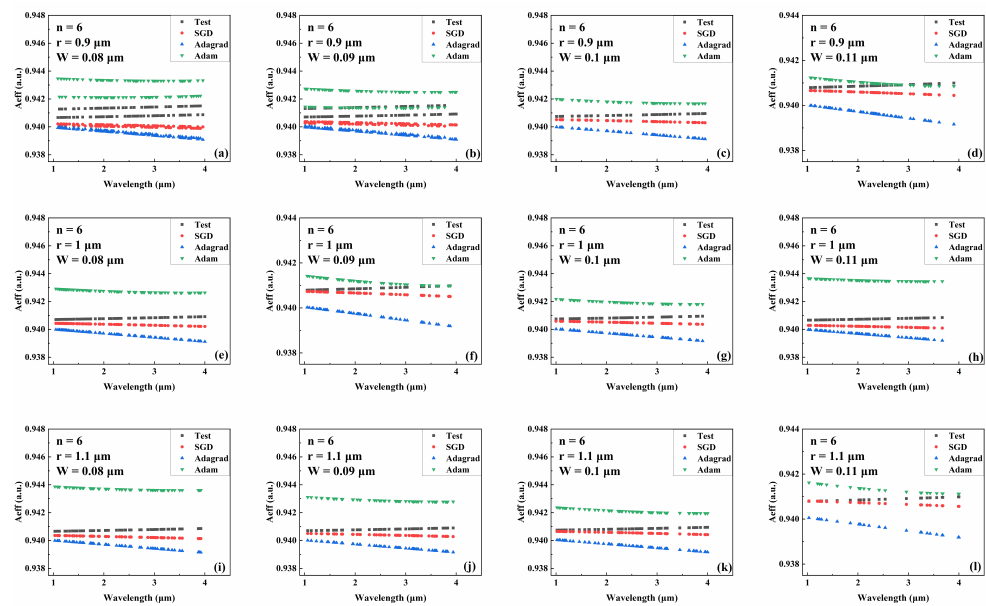
Figure 6. Comparison of the predicted and actual values of A ef f in the test data set of the network model trained by different optimizers for different combinations of core radius and cantilever width (number of cantilevers: 6). ( a ) r = 0.9 µ m, W = 0.08 µ m. ( b ) r = 0.9 µ m, W = 0.09 µ m. ( c ) r = 0.9 µ m,